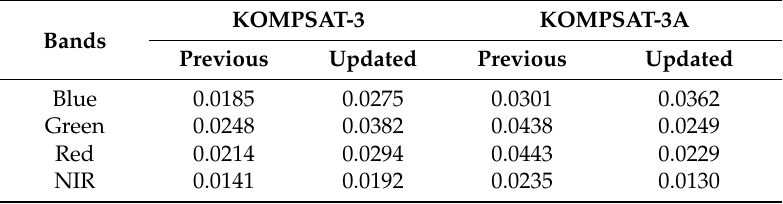
Table 5. Comparison of previous and updated DN to radiance coefficients of KOMPSAT-3 and -3A. Bands